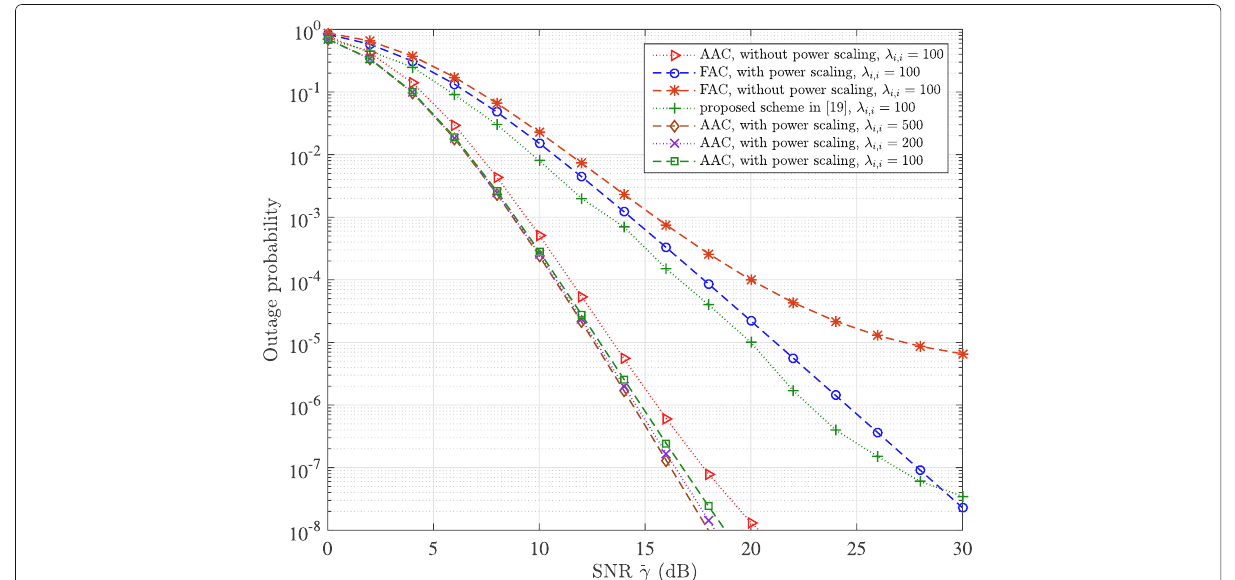
Fig. 4 Outage probability of the proposed joint relay-antenna selection versus transmit power with different values of λ i , i and K = 3